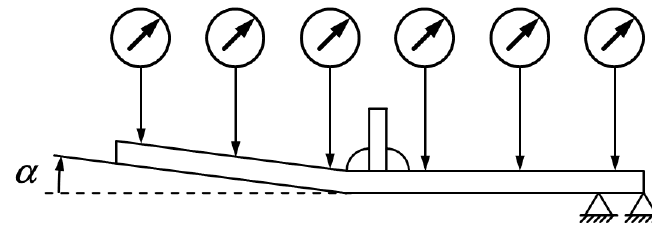
Figure 2. Procedure of distortion measurements.